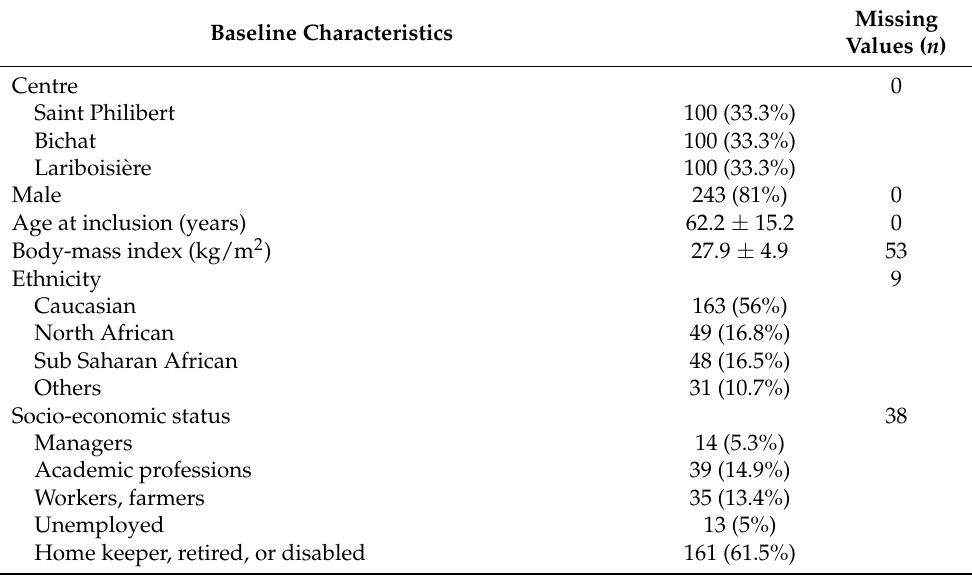
Table 1. Patients’ baseline